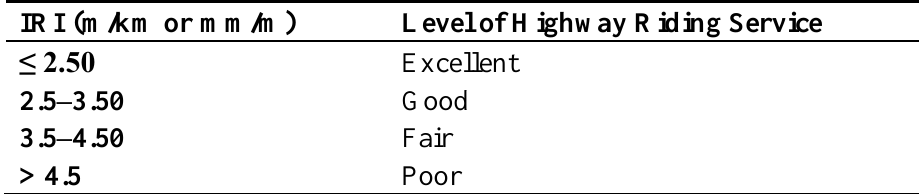
Table 4. IRI values and associated road surface